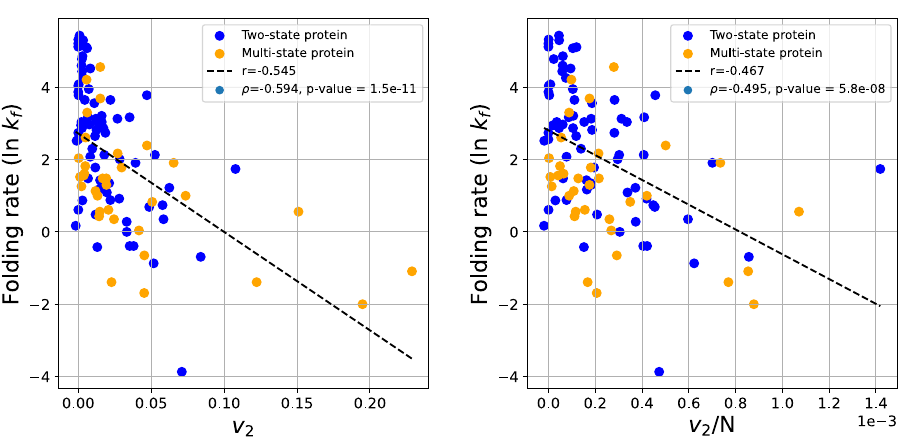
Figure 6. The protein folding rate as a function of v 2 (left) and v 2 /N (right) for all